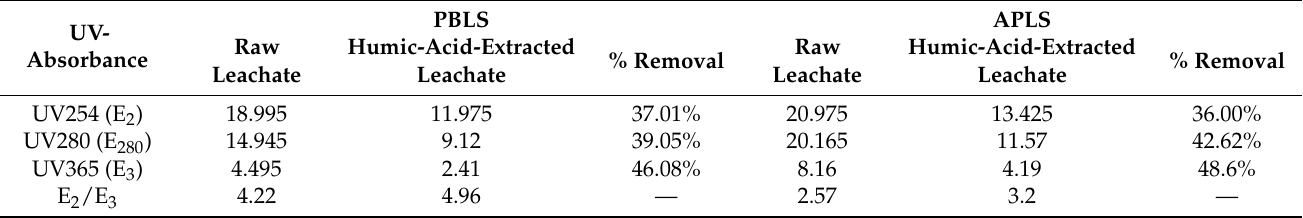
Figure 7. UV–Visible spectra for isolated humic acid ( a ) PBSL leachate and ( b ) APLS leachate. Table 2. Outcomes of UV–Vis absorbance analysis.